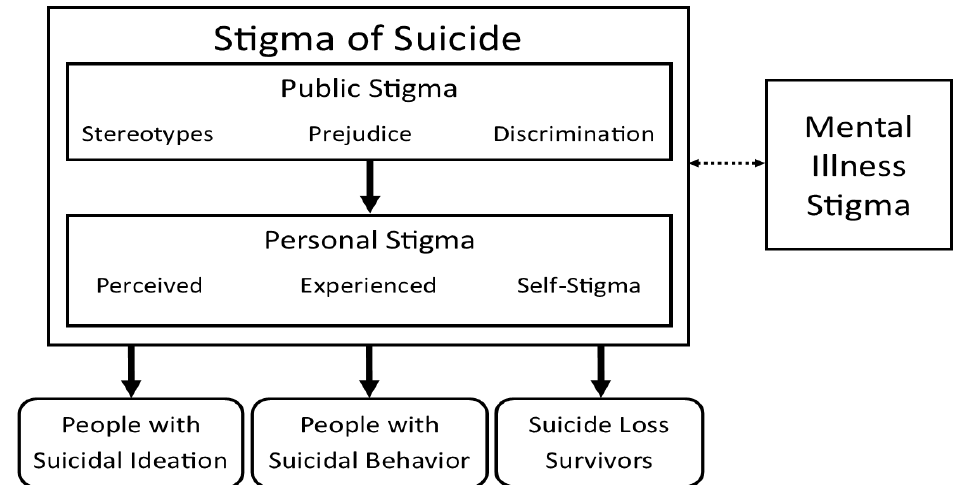
Figure 1. Model of public and personal stigma of suicide.